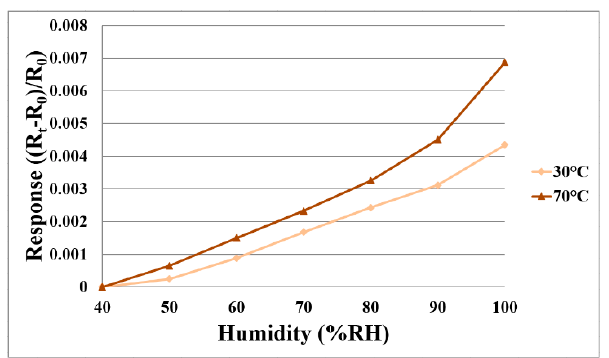
Figure 5. The correction curve of two micro humidity sensors.